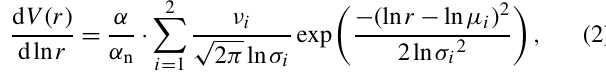
Nucleation-mode aerosol size spec- trometer (NMASS); ultra-high sen- sitivity aerosol size spectrometer (UHSAS); LAS